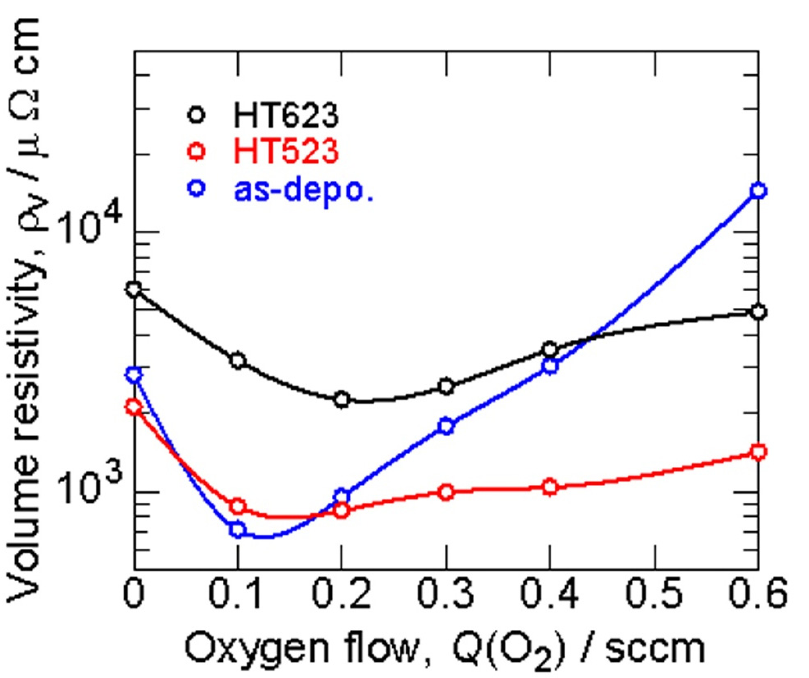
Figure 1. Effect of oxygen flow rate and heat treatment temperature on volume resistivity of the ITO50:Al 2 O 3 (PHS) thin films.